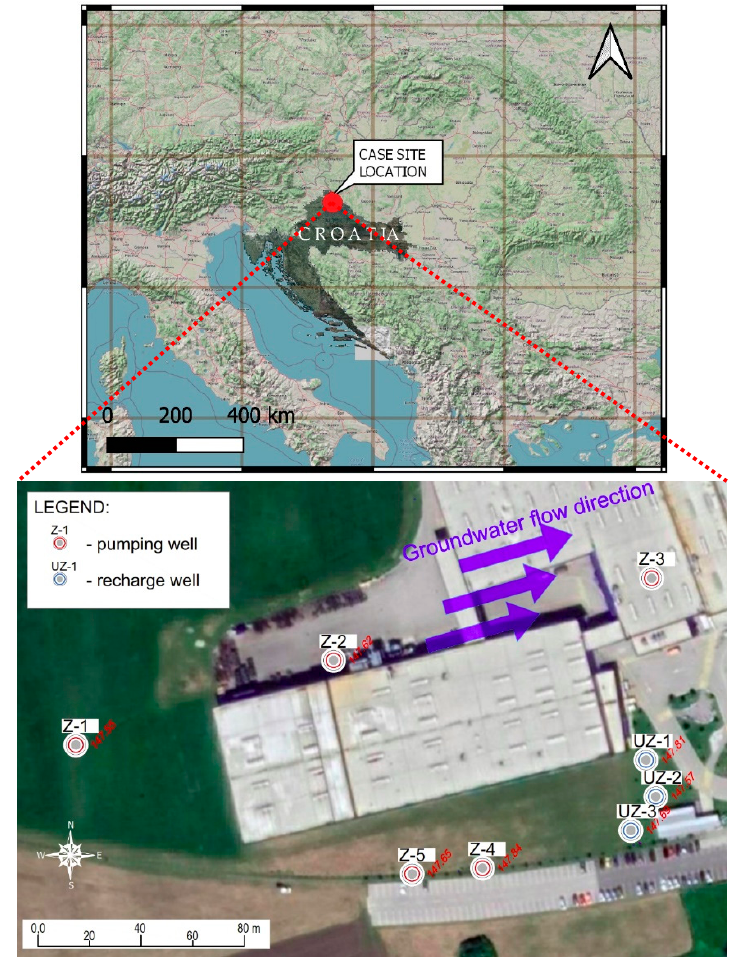
Figure 1. Case site location with groundwater flow direction and positions of wells.